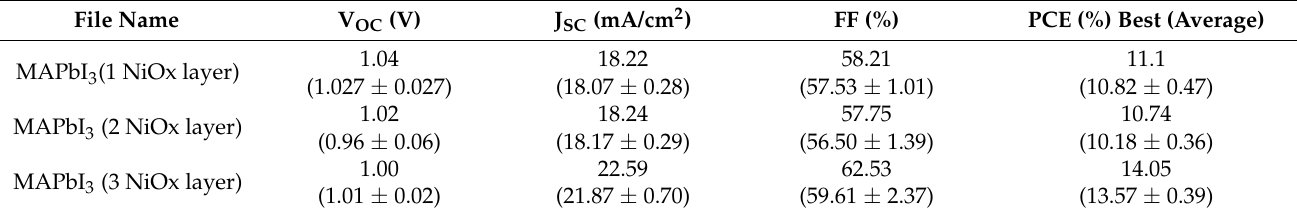
Table 1. The best (average) photovoltaic parameters of the of MAPbI 3 based PSCs for different layers of NiO X